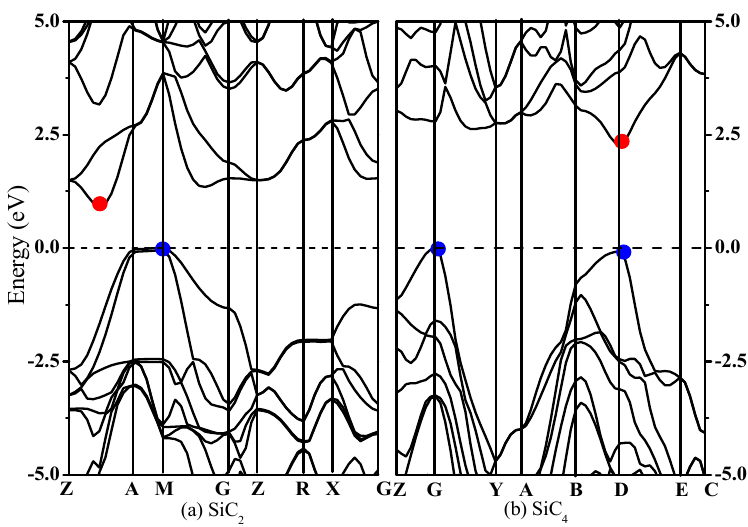
Figure 5. Electronic band structures of SiC 2 ( a ) and SiC 4 ( b ). The red and blue points indicate the conduction band minimum and valence band maximum, respectively.